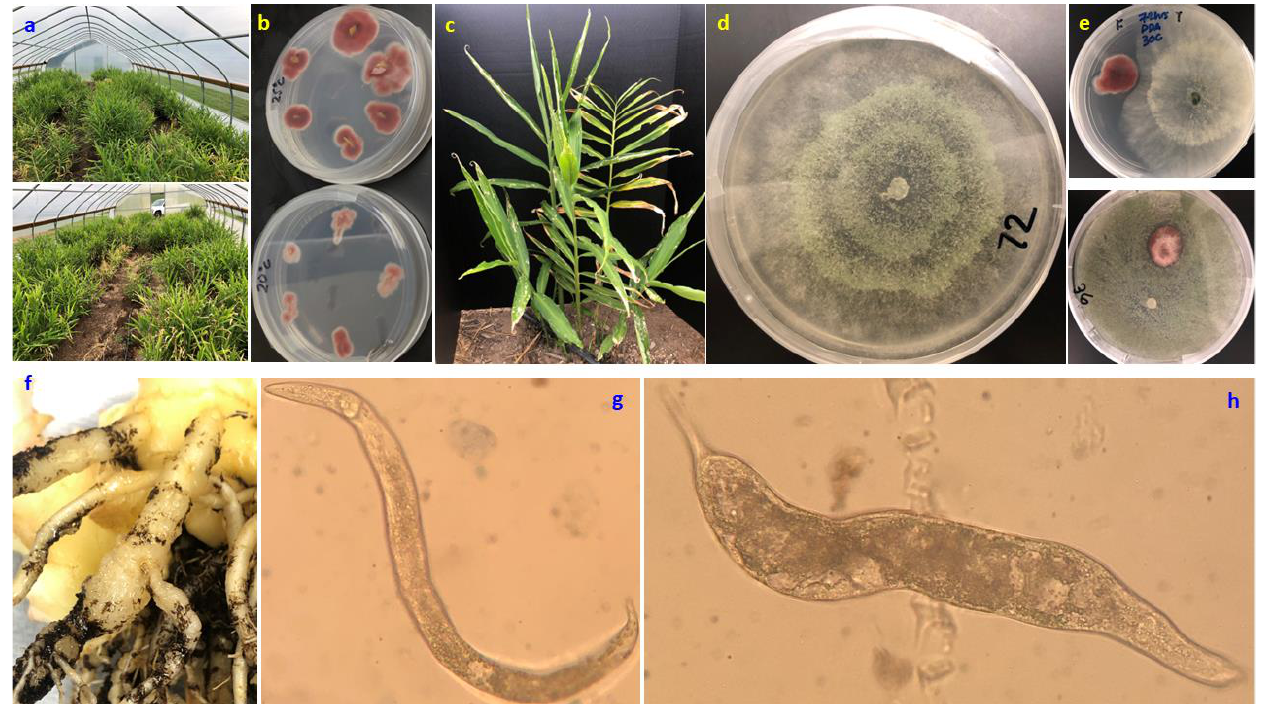
Figure 1. ( a ) front (top) and back (bottom) view of a high tunnel with pockets of affected areas, a typical spatial pattern of seed and diseases (SSDs); ( b , c ) isolation of Fusarium oxysporum f.sp. zin- giberi and yellowing symptom after artificial inouculation; ( d , e ) Trichoderma harziahum strain T-22 and dual cultures on potato dextrose agar (PDA) showing the interactions 3 days (top) and 9 days (bottom) after inoculation at 30 °C; ( f ) root knot symptom on ginger; ( g , h ) adult and female Meloido- gyne incognita